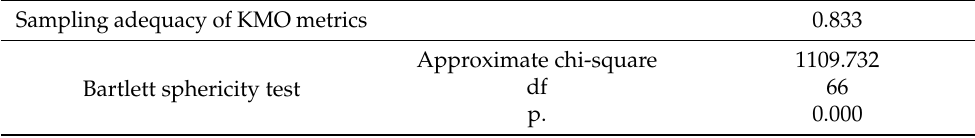
Table 9. KMO and Bartlett Tests of Psychological